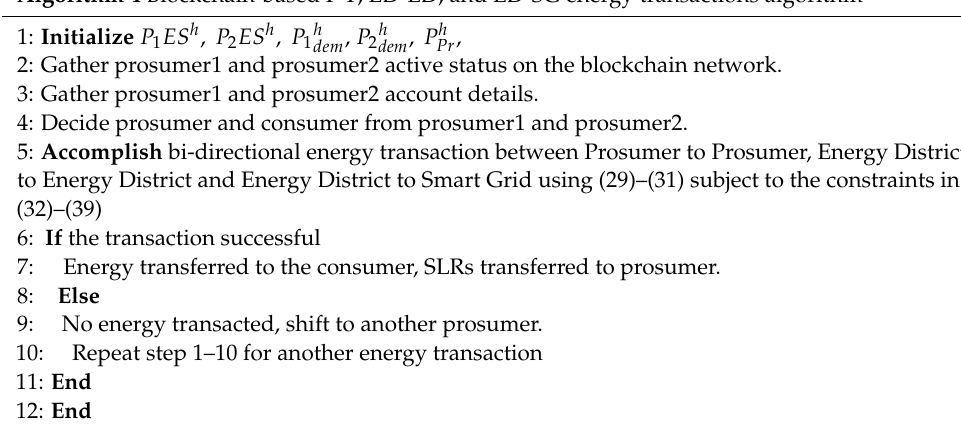
Algorithm 4 Blockchain-based P-P, ED-ED, and ED-SG energy transactions